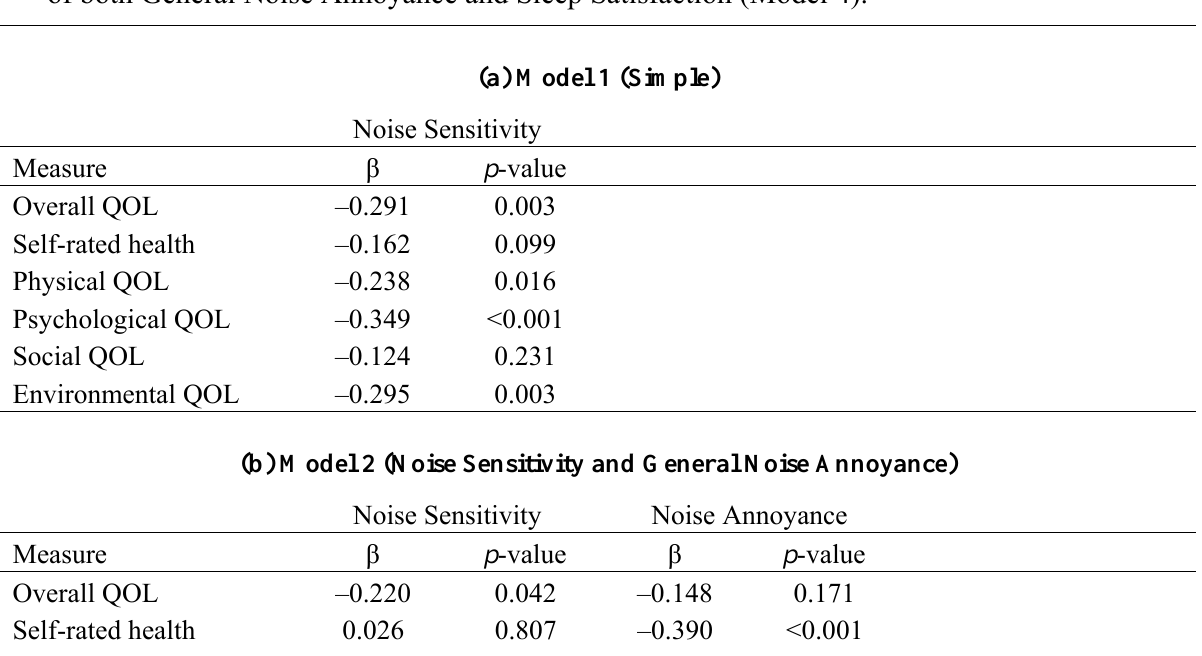
Table 2. Standardized regression coefficients ( β ) associated with the relationship between Noise Sensitivity and measures of HRQOL (where the Physical subscale has the item reflecting sleep satisfaction removed) modeled using Ordinary Least Squares Linear Regression with (a) Noise Sensitivity alone (Model 1), (b) simultaneous inclusion of Noise Annoyance (Model 2) or (c) Sleep Satisfaction (Model 3), and (d) simultaneous inclusion of both General Noise Annoyance and Sleep Satisfaction (Model